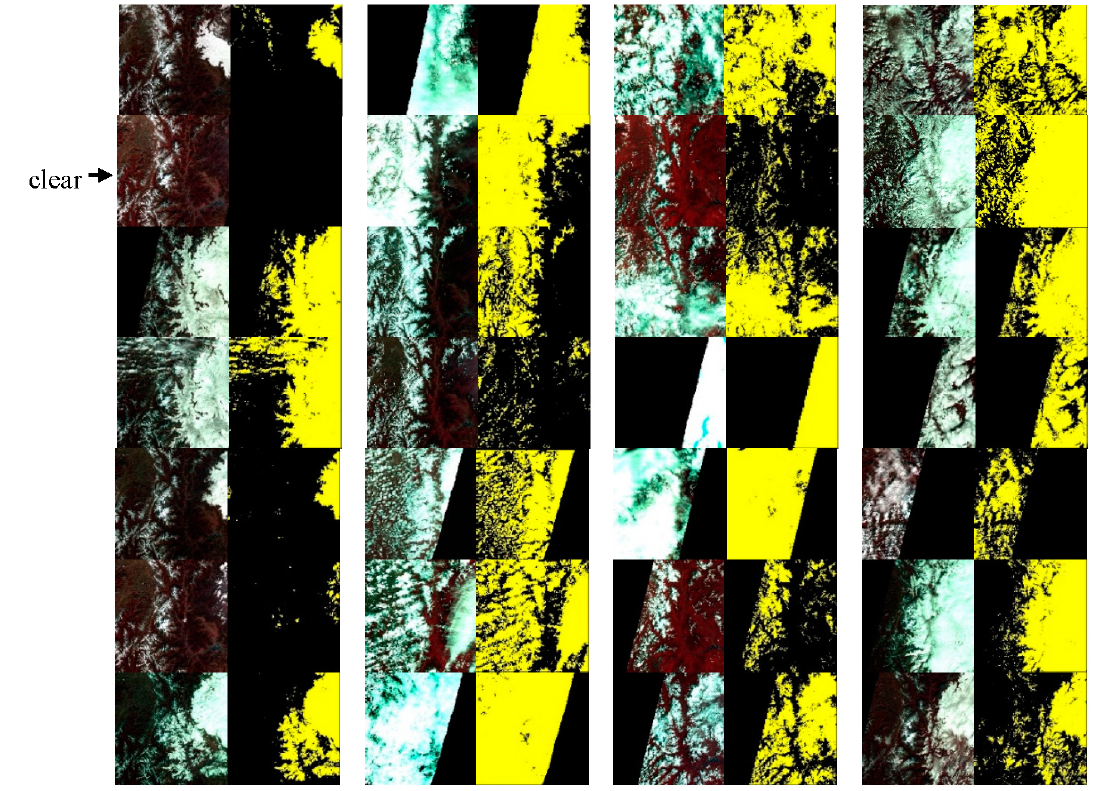
Figure 8. Examples of performance of the proposed algorithm for 150 km × 150 km Mt. Gongga area for the middle month of each season of the year 2011. The standard seasonal definition for the Northern Hemisphere adopted by the climate modeling community is used, where spring is defined by the months March to May. False color composited images with bands 4, 3, and 2 in red , green and blue , respectively, are shown on the left, and cloud masks are shown on the right with yellow color.